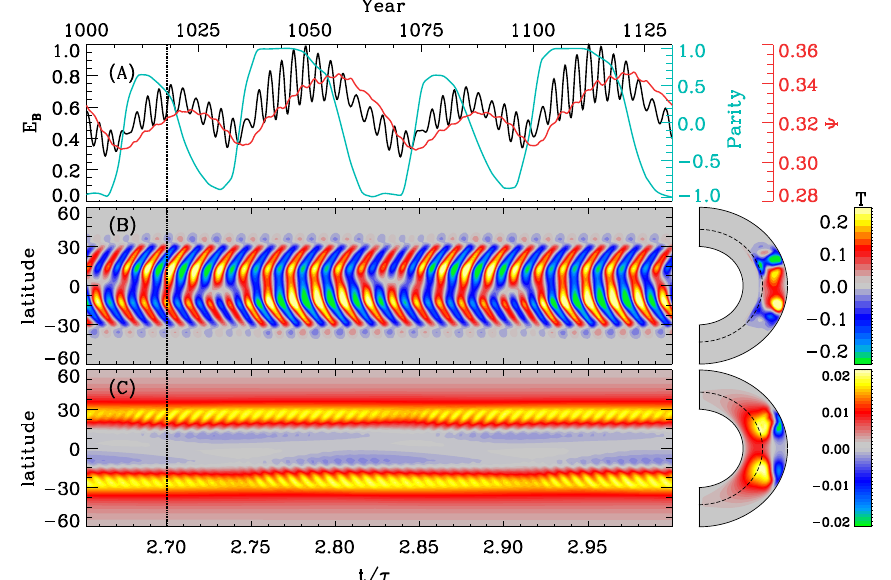
Fig. 4. Simulation 2, a non-kinematic a 2 X dynamo exhibiting parity modulation. (A) Normalized magnetic energy in black, the shear proxy ( W ) integrated in the meridional plane in red, and the parity in light blue. (B) Toroidal magnetic fi eld in a time-latitude diagram extracted at 0.85R and (C) the angular velocity fl uctuation ( X 0 ( r , h , t )/ X ( r , h )) in the same con fi guration. The meridional cuts of the toroidal fi eld B and angular velocity perturbation X 0 plotted at right of the time-latitude diagrams are extracted at t / s = 2.7, as indicated by the dash-dotted line segments on the corresponding time-latitude diagrams.